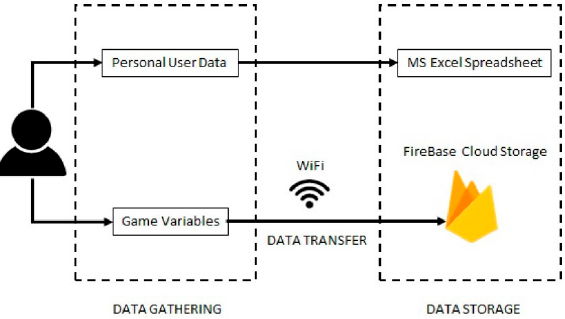
Figure 2. Data Gathering and Data Storage Flow.